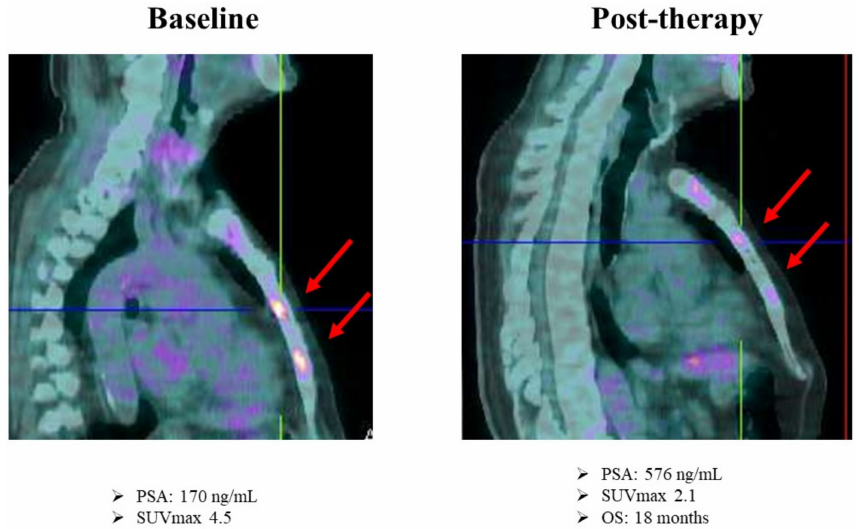
Figure 7. 18F-FDG PET at baseline and after three cycles of Ra-223. The red arrows indicate metaboli- cally active bone